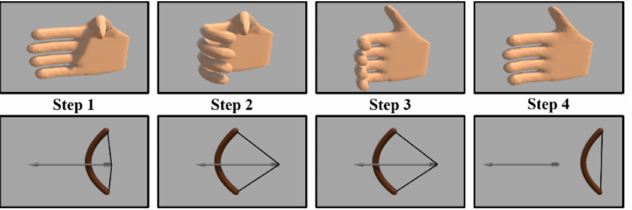
Figure 8. Schematic of virtual archery game. The user intends to control the virtual hand by the less-affected hand of the